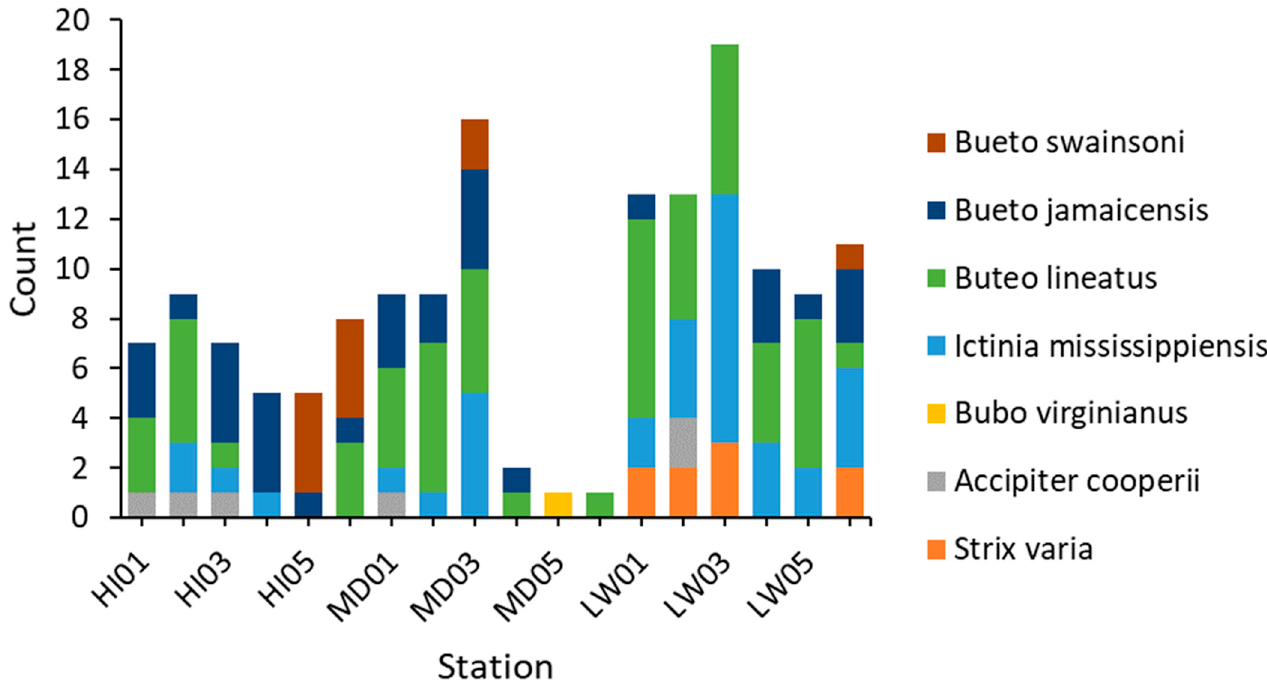
Figure 3. Species richness within each raptor survey station along the urban-to-rural gradient in the Great Trinity Forest, Dallas, TX, USA. “HI01” indicates the station with greatest level of urbanization, whereas “LW06” indicates the station with the lowest level of urbanization. The count for Falco sparverius is not shown.